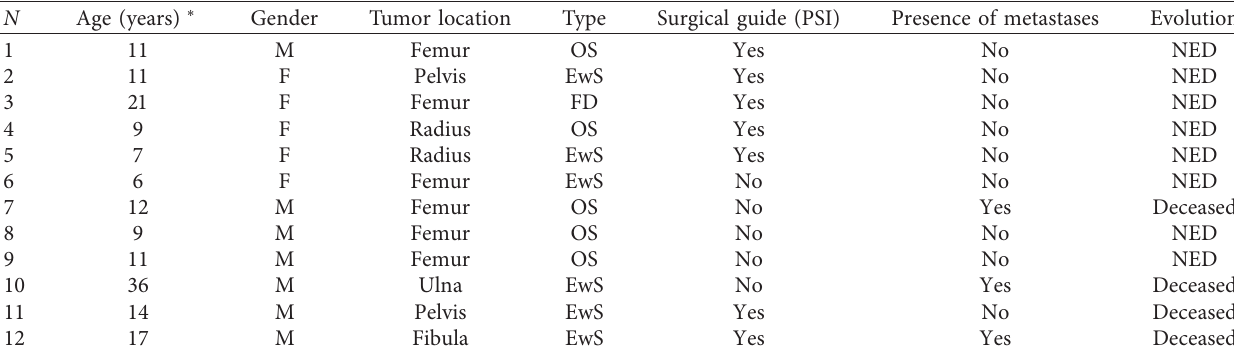
Table 1: Patients’